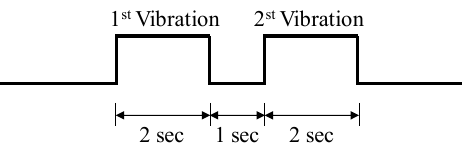
Figure 9. Time chart of stimulation.